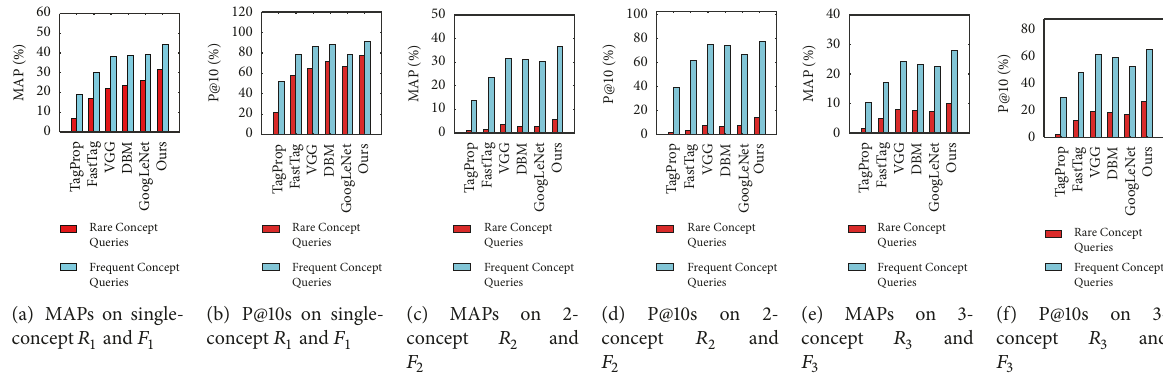
Figure 5: MAPs and P@10s (%) of semantic image retrieval for rare concepts and frequent concepts on NUS-WIDE.